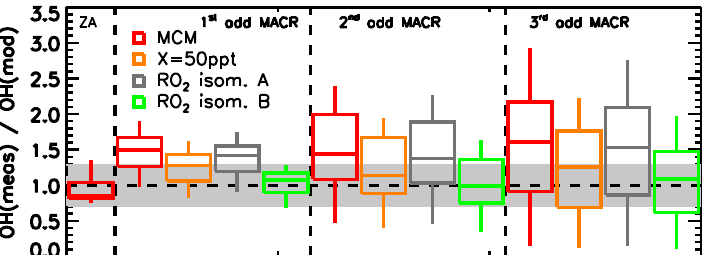
Figure 5. Ratio of measured (DOAS) to modelled OH concentrations for the four parts of the experiment on 11 August 2011 applying different model approaches: MCM, MCM with additional generic OH recycling (“X”), and MCM with additional RO 2 isomerization schemes (case A and B; see Table 4). The grey shaded area gives the range of agreement of modelled and calculated OH concentrations that is achieved in reference